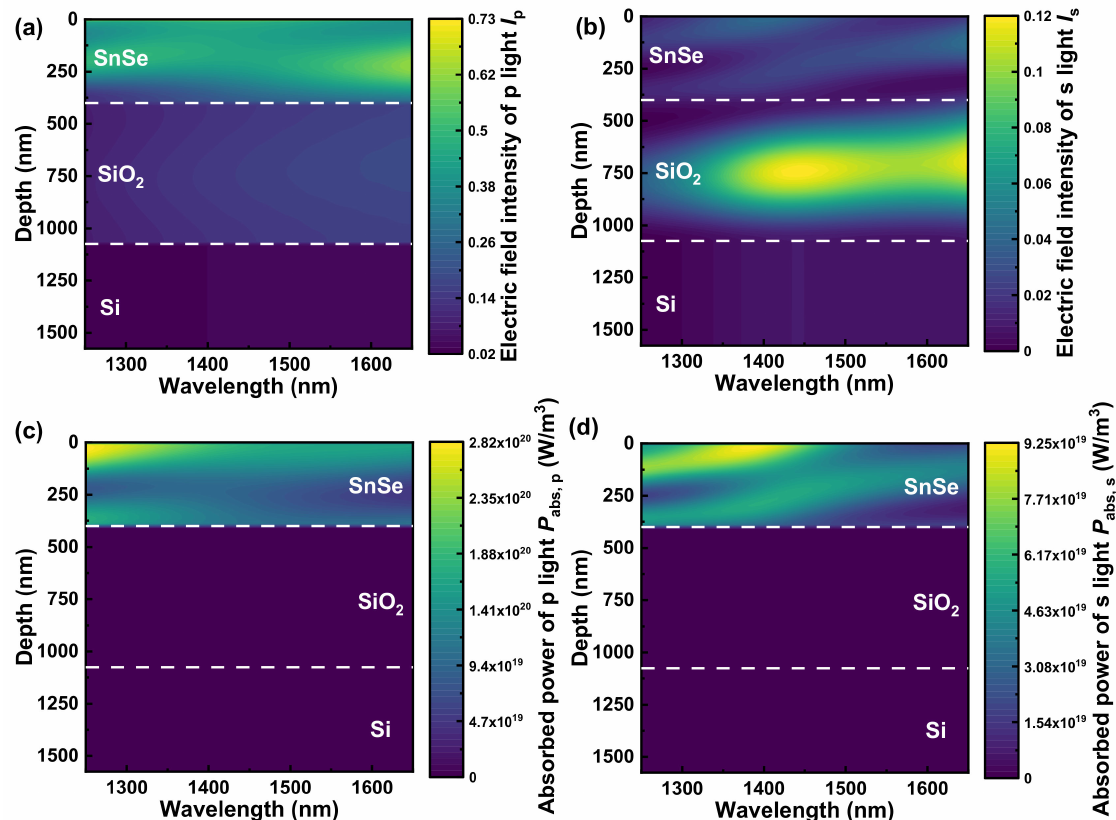
Figure 4. The mechanism for the near-infrared broadband polarizer based on SnSe ( d SnSe = 400 nm)- SiO 2 ( d SiO = 675 nm)-Si multilayer structure. The contour maps of the electric field intensity of ( a ) p 2 and ( b ) s light ( I p and I s ), and the absorbed power of ( c ) p and ( d ) s light ( P abs,p and P abs,s ) at the incident angle of 75 ◦